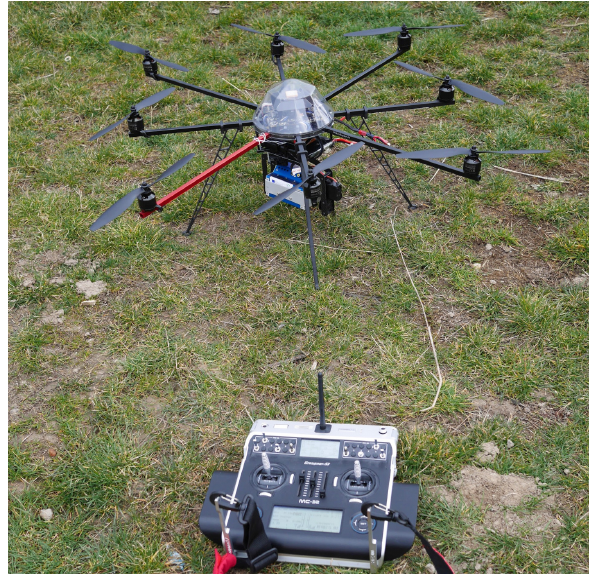
Figure 2. ARF MicroKopter Okto XL equipped with multispectral camera µ-MCA Snap